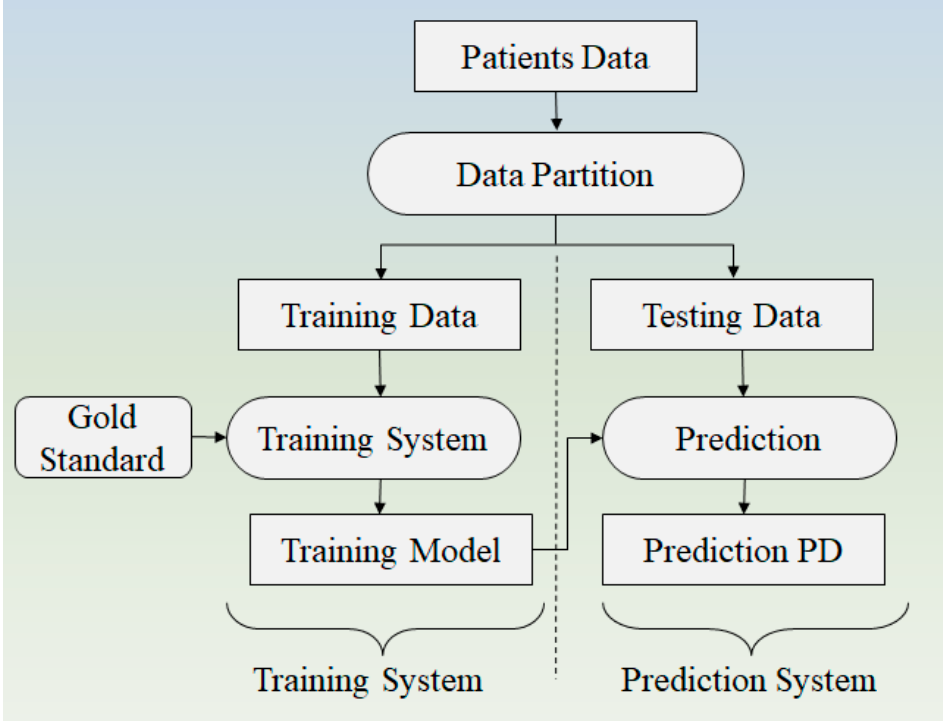
Figure 9. Proposed architecture for early detection of PD [6].